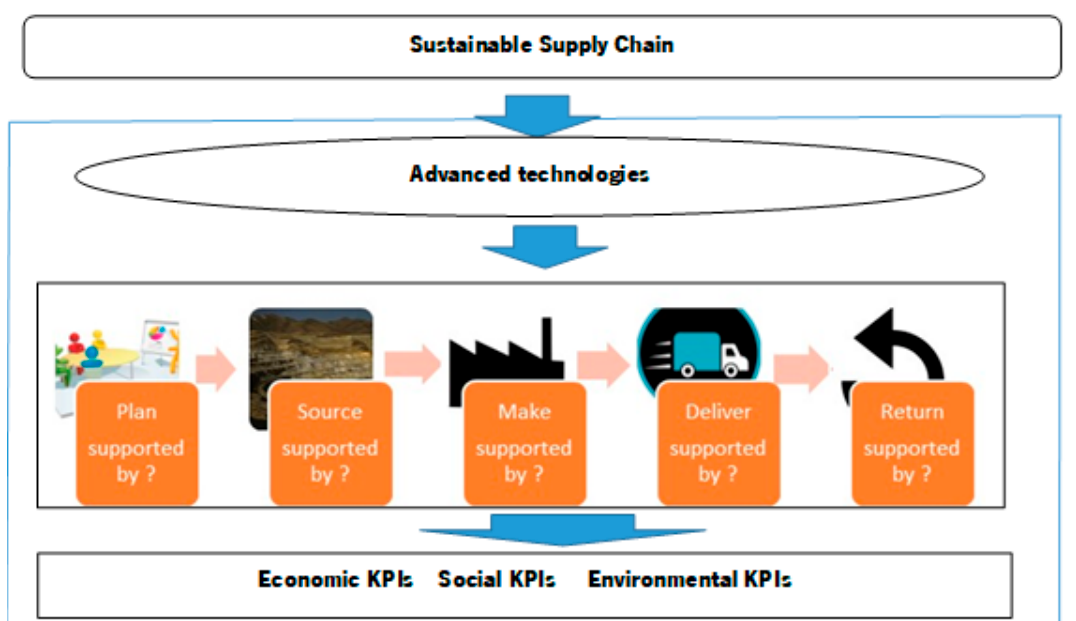
Figure 1. Conceptual model developed in this